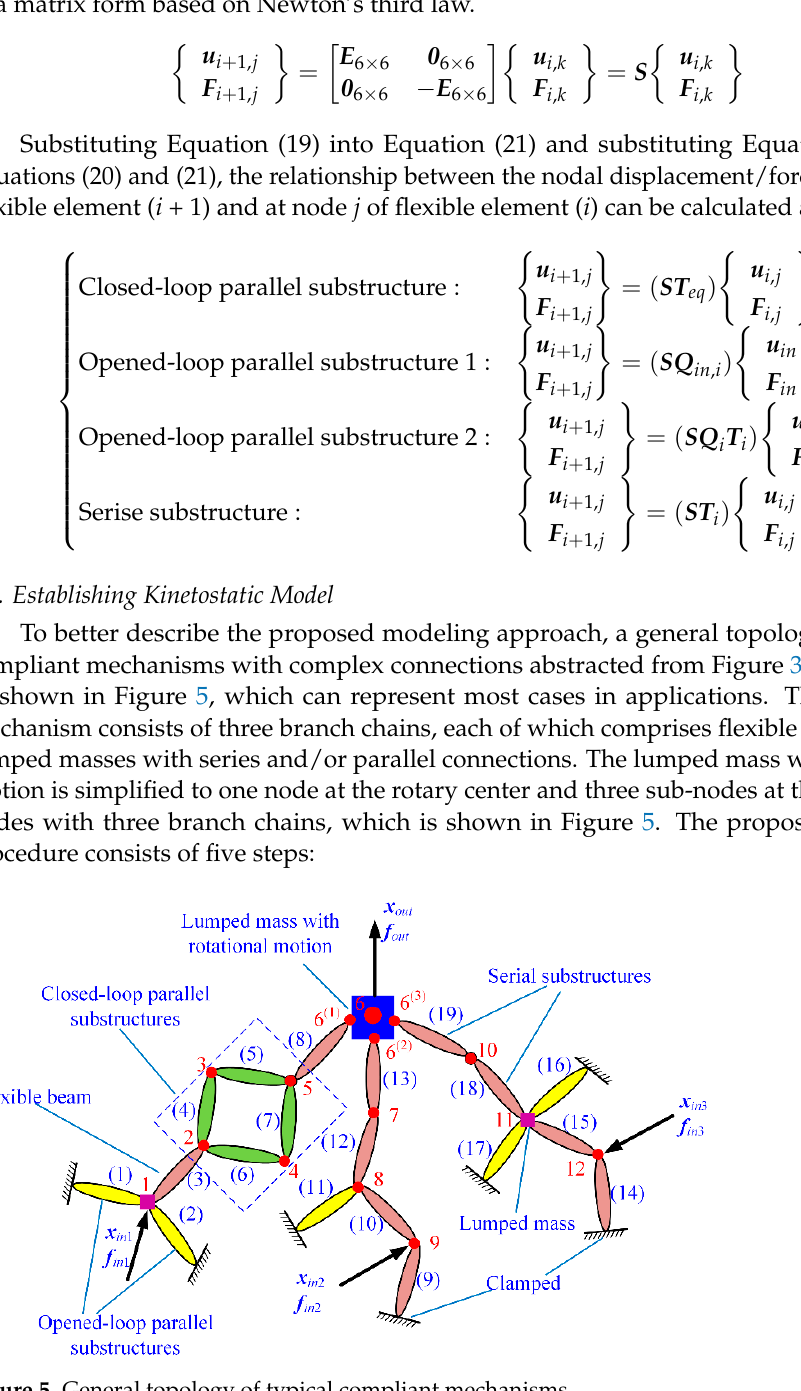
( b ) Figure 6. Nodal displacements and nodal forces: ( a ) the flexible beam; ( b ) the lumped mass.